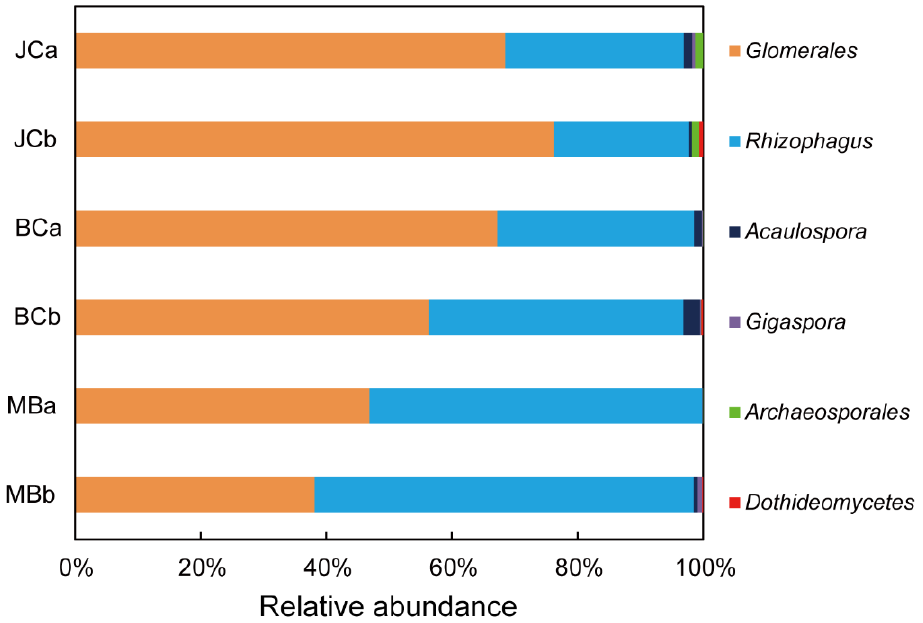
Figure 2. The soil AMF community composition.